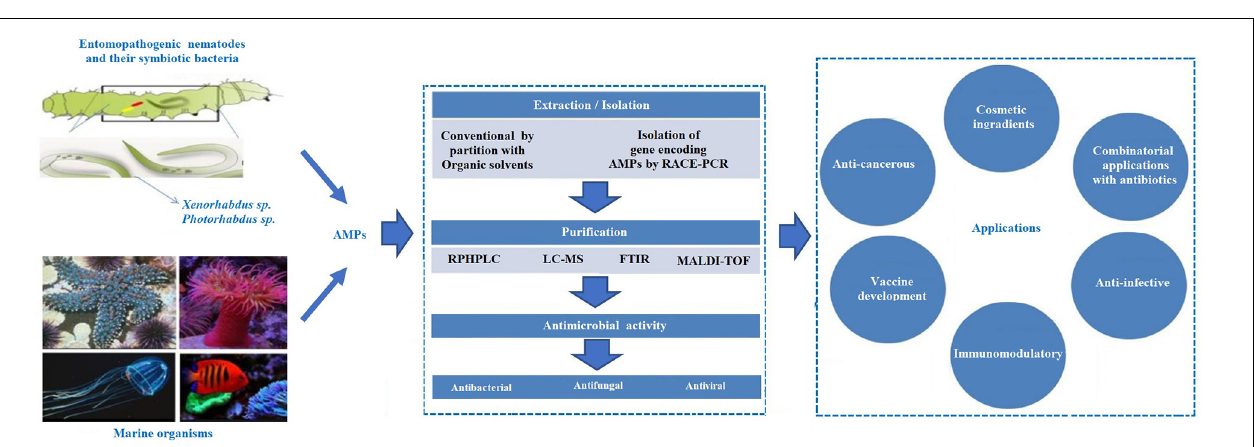
FIGURE 2 | Schematic representation of the antimicrobial peptides (AMPs) extracted from the different source and their